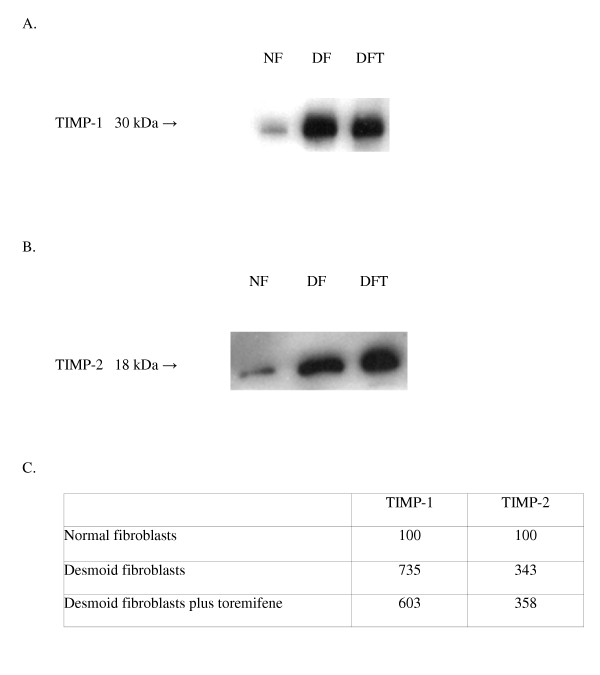
Western blot analysis of TIMP-1 and TIMP-2 secreted into the medium. Panel A; TIMP-1. Panel B; TIMP-2. The samples are as follows: NF, normal fibroblasts; DF, desmoid fibroblasts; DFT, desmoid fibroblasts plus toremifene. Similar results were obtained in four separate experiments. Panel C. The absolute counts, obtained by densitometric analysis, were converted to percentages assuming the level of normal fibroblasts as 100%.